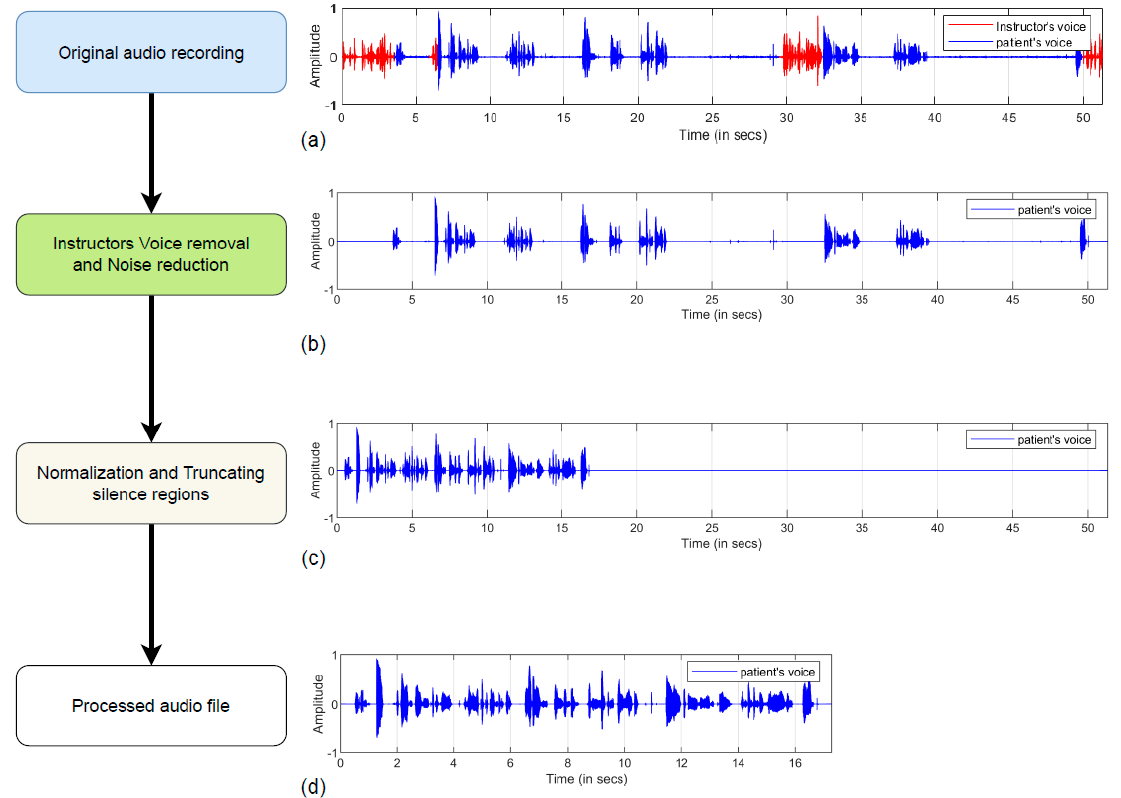
Figure 2. Waveforms of ( a ) original audio signal, ( b ) audio after removing instructor’s voice and applying noise reduction, ( c ) audio after normalization and truncating silence, and ( d ) final pro-cessed audio file.